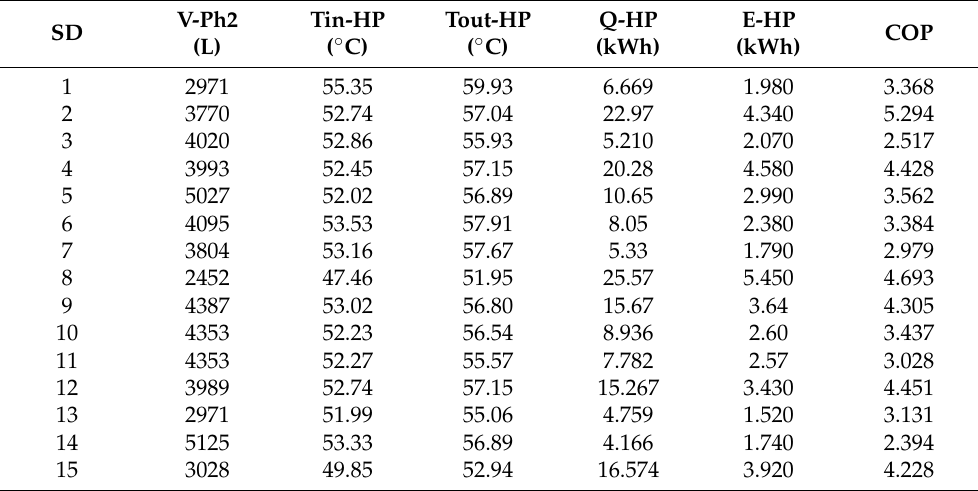
Table 3. Performance of heat pump of the system during the second phase of its